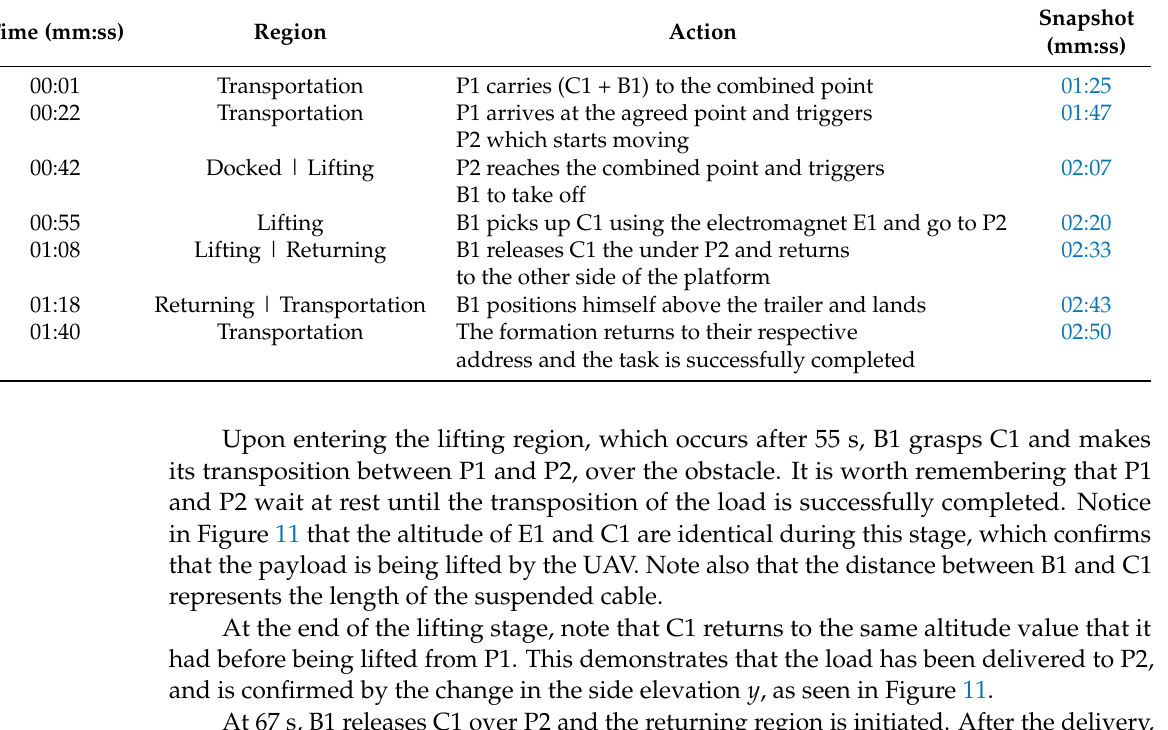
Table 2. Sequence of events of the experiment 1.